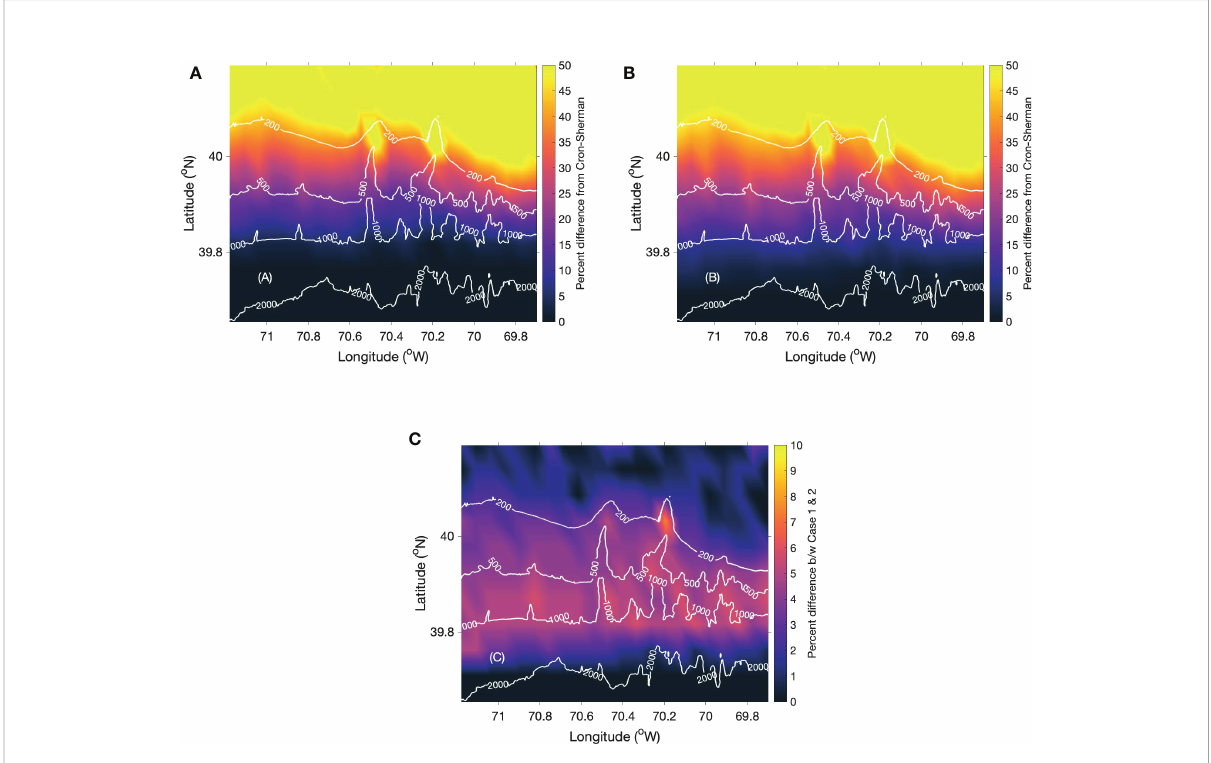
vertical coherence. Two transects along the latitude as shown in Figure 6 were chosen to study the variation in noise gain from shallow water to deep-water. The fi rst transect (transect a) was away from the canyon axis with a gradually decreasing bathymetry from the continental shelf to deep water. A second transect (transect b) close to the axis of the Alvin canyon was chosen to study the in fl uence of bathymetric variation. The estimated NG of both transects and corresponding bathymetry are shown in Figures 7A, B respectively. NG estimates using the isotropic (black dashed line) and the Cron-Sherman (green dashed line) model are also plotted to compare with the test